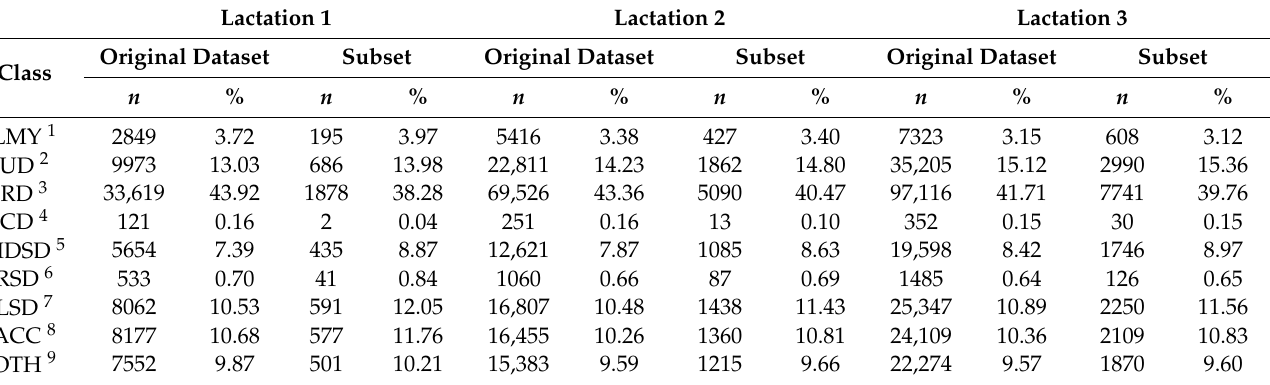
Table 1. Culling categories between 2017 and 2018 according to the breeding documentation in the original dataset and the selected